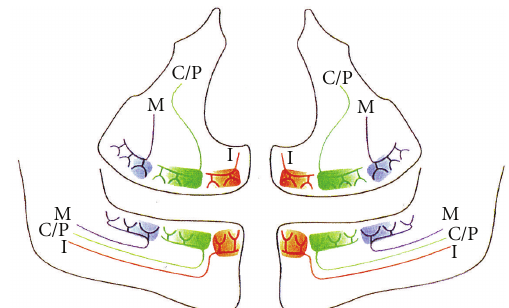
Figure 1: Schematic illustration of a panoramic radiograph with peripheral nerves innervating the di ff erent tooth groups. Red colour (I) illustrates the innervation of maxillary and mandibular incisors. Green colour (C/P) illustrates the innervation of maxillary and mandibular canines and premolars. Blue colour (M) illustrates the innervation of maxillary and mandibular molars. This illustration is reproduced with permission from Acta Odontologica Scandinavica [7].